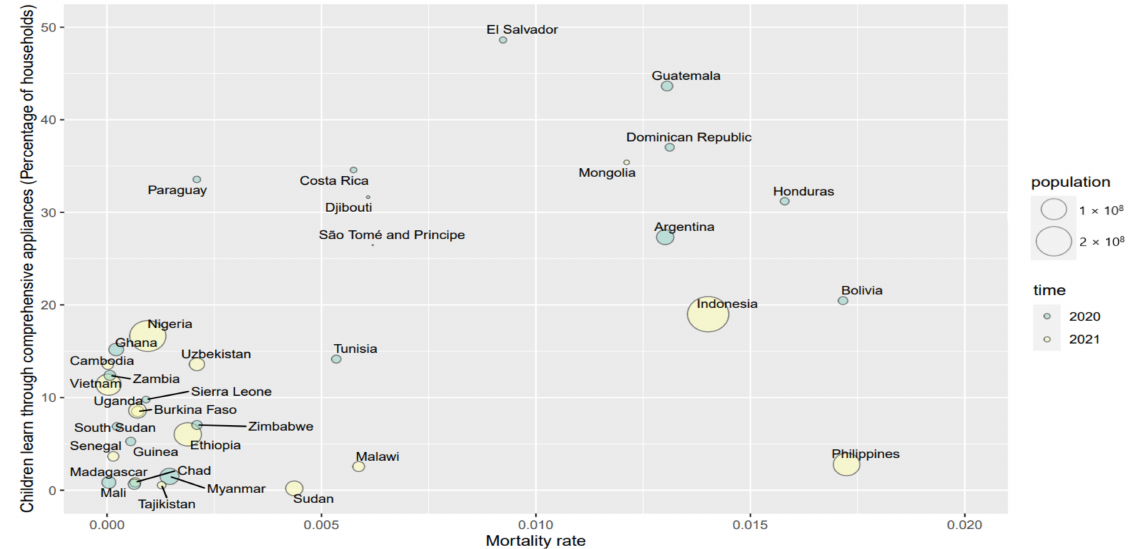
Figure 7. The pattern of the mortality rate and comprehensive appliances in children’s education since school